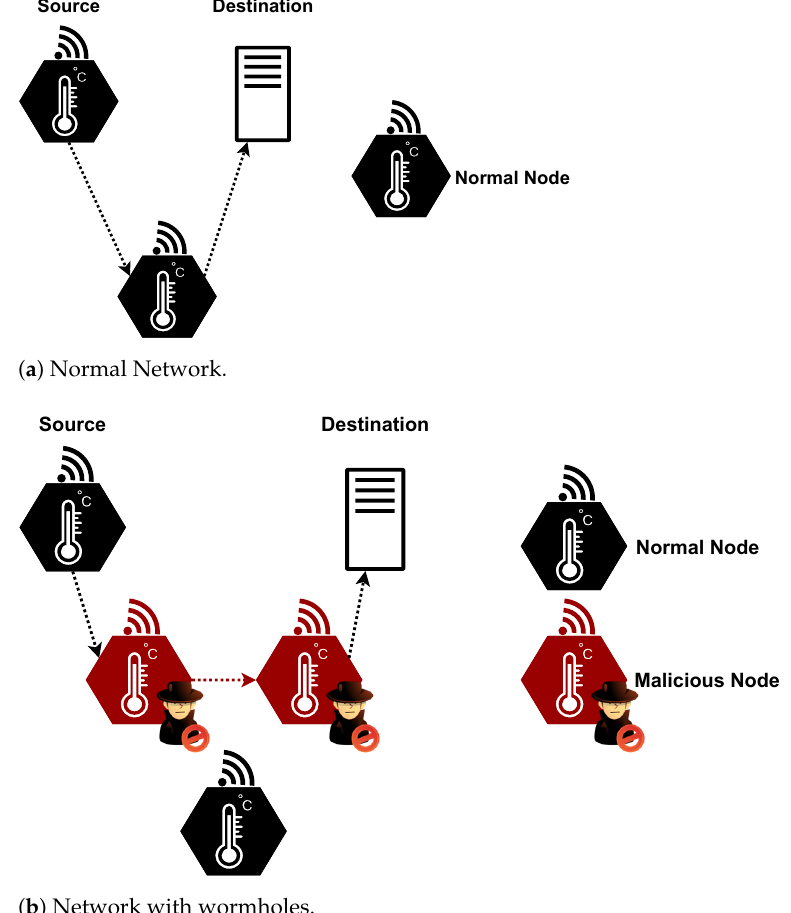
Figure 10. Wormhole attack example. Image adapted from